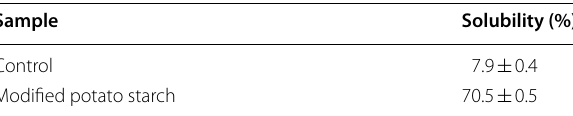
Table 3 Solubility of the native and bl-GBE modified potato starch